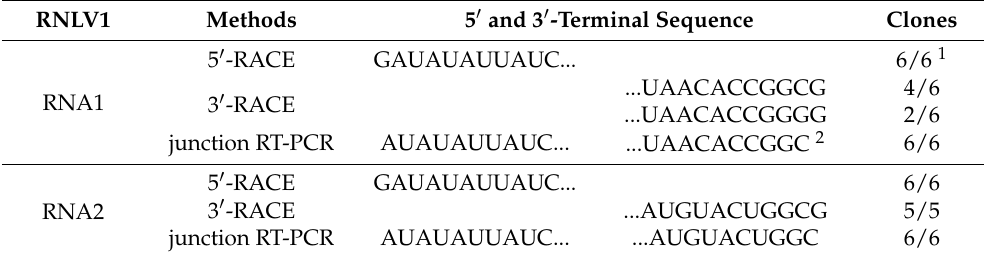
Figure 1. Images of dwarfed rice plants in fields and RT-PCR detection of virus infections. ( a ) Images of rice plants showing dwarf symptoms in a rice field in Shanghai City (left image) and in the Zhejiang Province (right image). White arrows indicate the plants showing dwarf symptoms. ( b ) RT-PCR detection of virus infection in the rice plants shown in ( a ) using primers designed according to the contig3 sequence (384 bp), the contig15 sequence (303 bp), the contig3206 sequence (366 bp), and the contig3545 sequence (279 bp), respectively. Table 1. Terminal sequences of RNLV1 RNA1 and